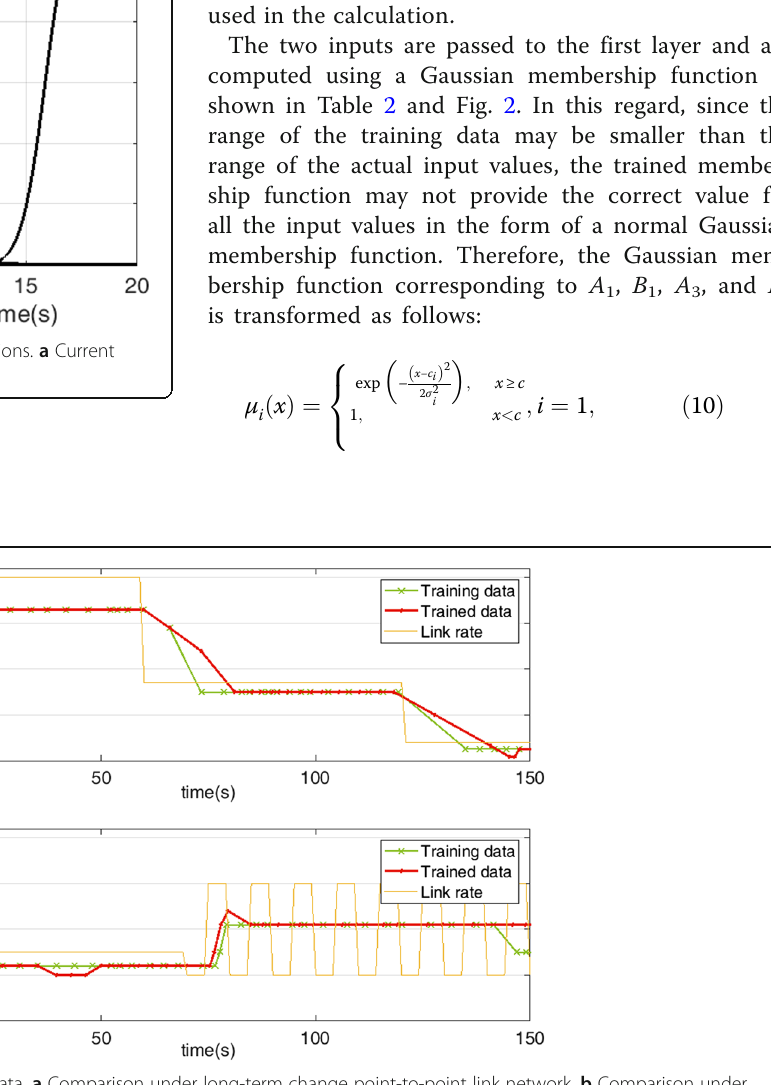
Fig. 5 Comparison of training data and trained data. a Comparison under long-term change point-to-point link network. b Comparison under short-term change point-to-point link